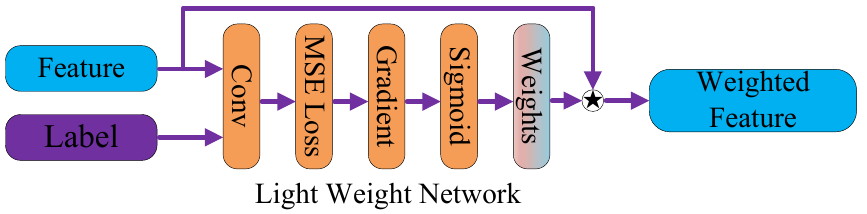
Figure 4. Lightweight target-aware attention learning